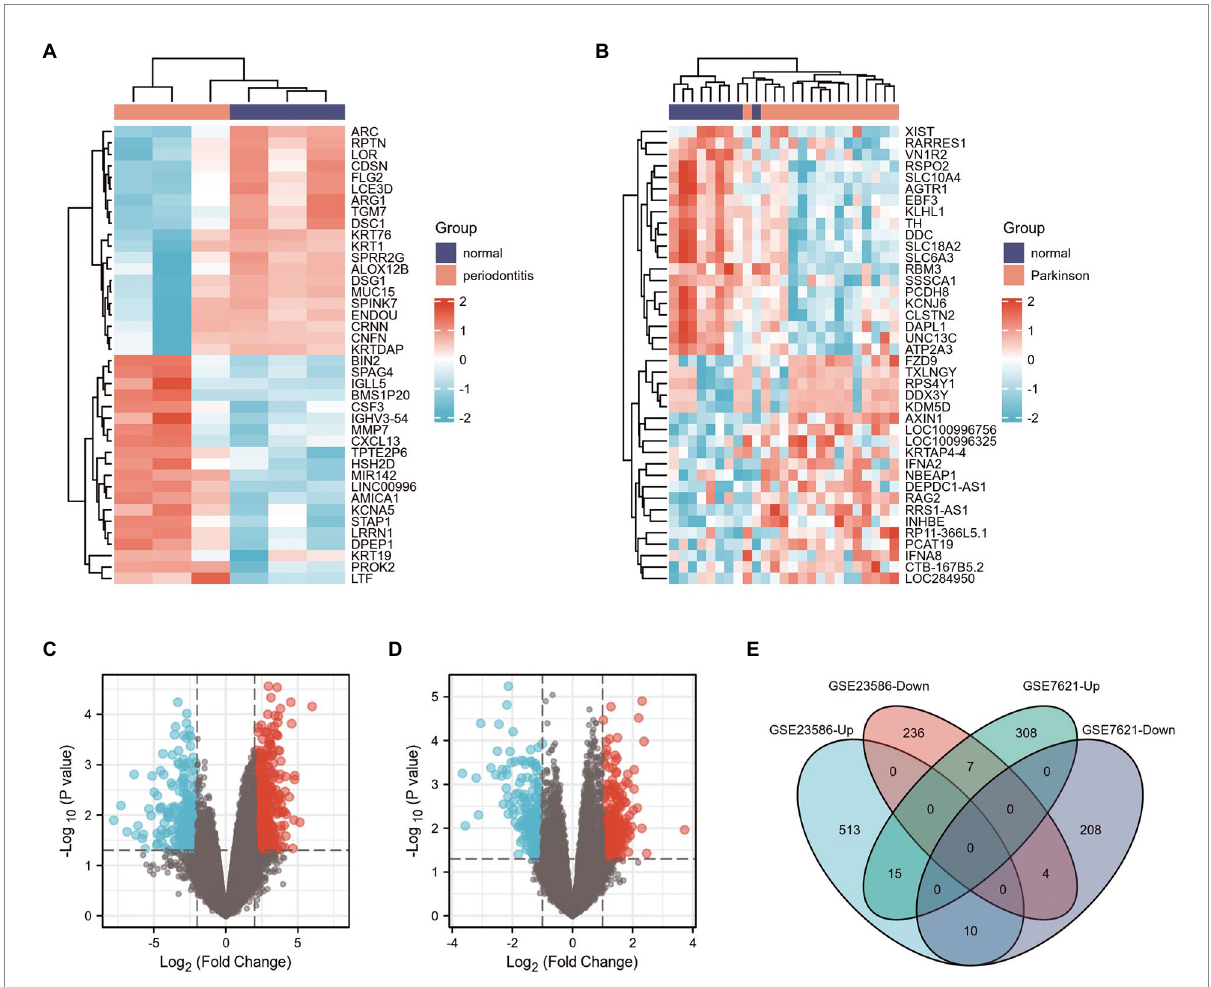
FIGURE 2 Screening of DEGs in GSE23586 and GSE7621 datasets. (A) Heatmap of DEGs between the normal sample and periodontitis sample in GSE23586 dataset. (B) Heatmap of DEGs between the normal sample and Parkinson’s disease sample in GSE7621 dataset. Red rectangles represent high expression, and blue rectangles represent low expression. (C) Volcano plot of DEGs between the normal sample and periodontitis sample in GSE23586 dataset. (D) Volcano plot of DEGs between the normal sample and Parkinson’s disease sample in GSE7621 dataset. Red plots represent upregulated genes, the black plots represent nonsignificant genes, and the blue plots represent downregulated genes. (E) Venn diagram of common DEGs from GSE23586 (|logFC| >2, and p < 0.05) and GSE7621 (|logFC| >1, and p < 0.05)